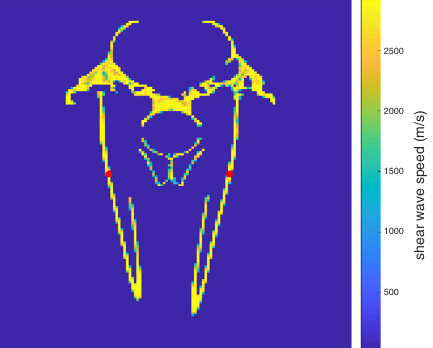
Figure 6. Receiver positions shown by red full circles on a slice of the skull with values of shear wave speed. The background material is water.